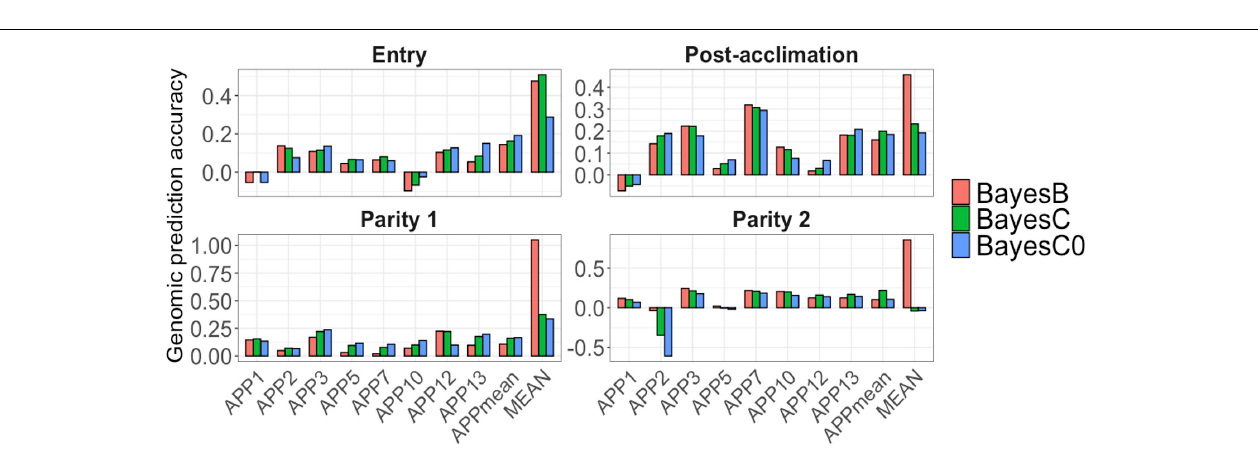
FIGURE 4 | Genomic prediction accuracies ( y -axis) for the seroconverted data for influenza A virus (IAV), Mycoplasma hyopneumoniae (MH), and porcine circovirus type 2 (PCV2) using BayesB. The x -axis represents the different time-points of data collection. The colors correspond to the minimum % of seropositive animals within a contemporary group.